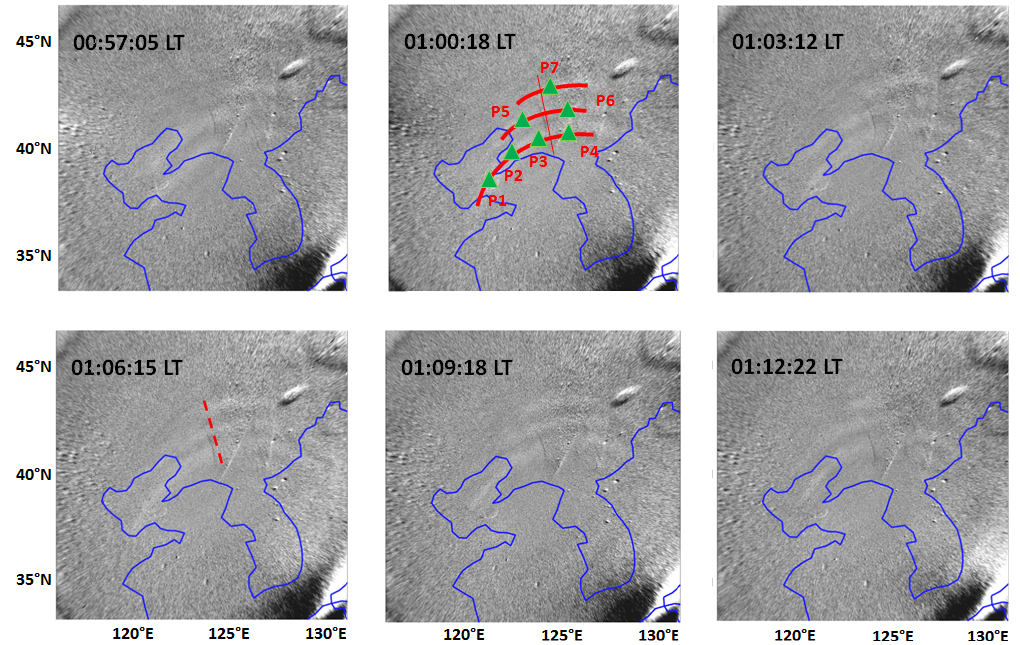
Figure 6. Time sequence of OI 630.0nm airglow emission perturbation images observed by the Donggang station from 00:57:05– 01:12:22LT on the night of 4 October 2016. Green triangles (P1–P7) in the red arcs are used as ray-tracing sampling points. The blue line in each panel represents the coastline.